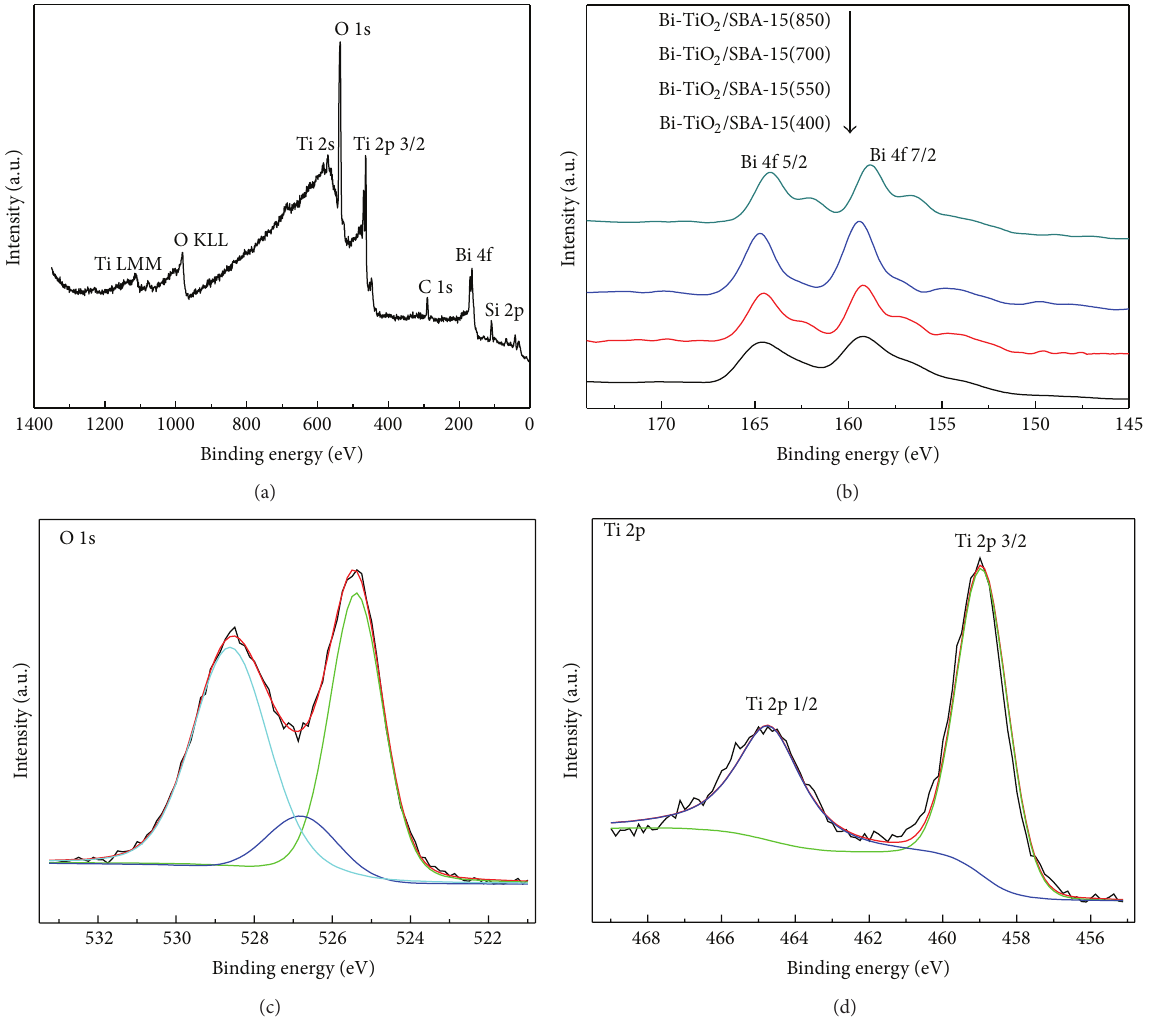
Figure 4: XPS survey spectrum of Bi-TiO 2 /SBA-15 (a), the high-resolution XPS spectra of Bi 4f region (b), O 1s (c), and Ti 2p (d).